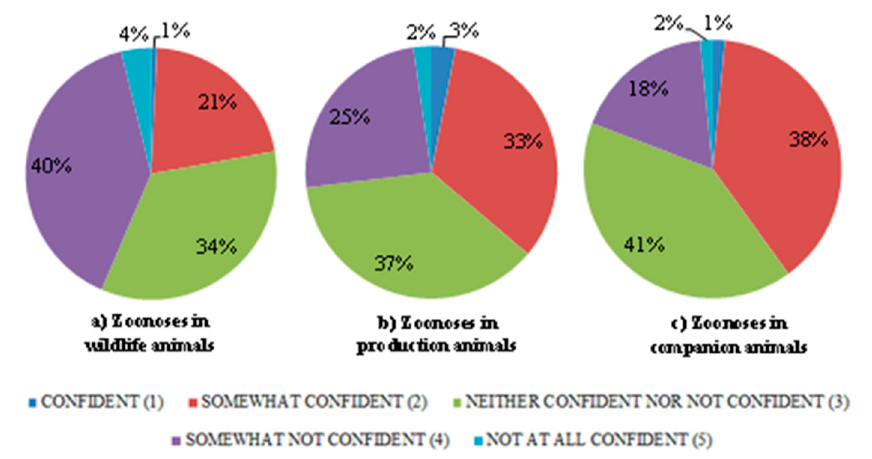
Figure 3. Responses of final-year veterinary student (n = 77) survey respondents to statements on self-efficacy in diagnosing zoonoses in different animal groups: ( a ) Wildlife animals, ( b ) Production animals, ( c ) Companion animals.